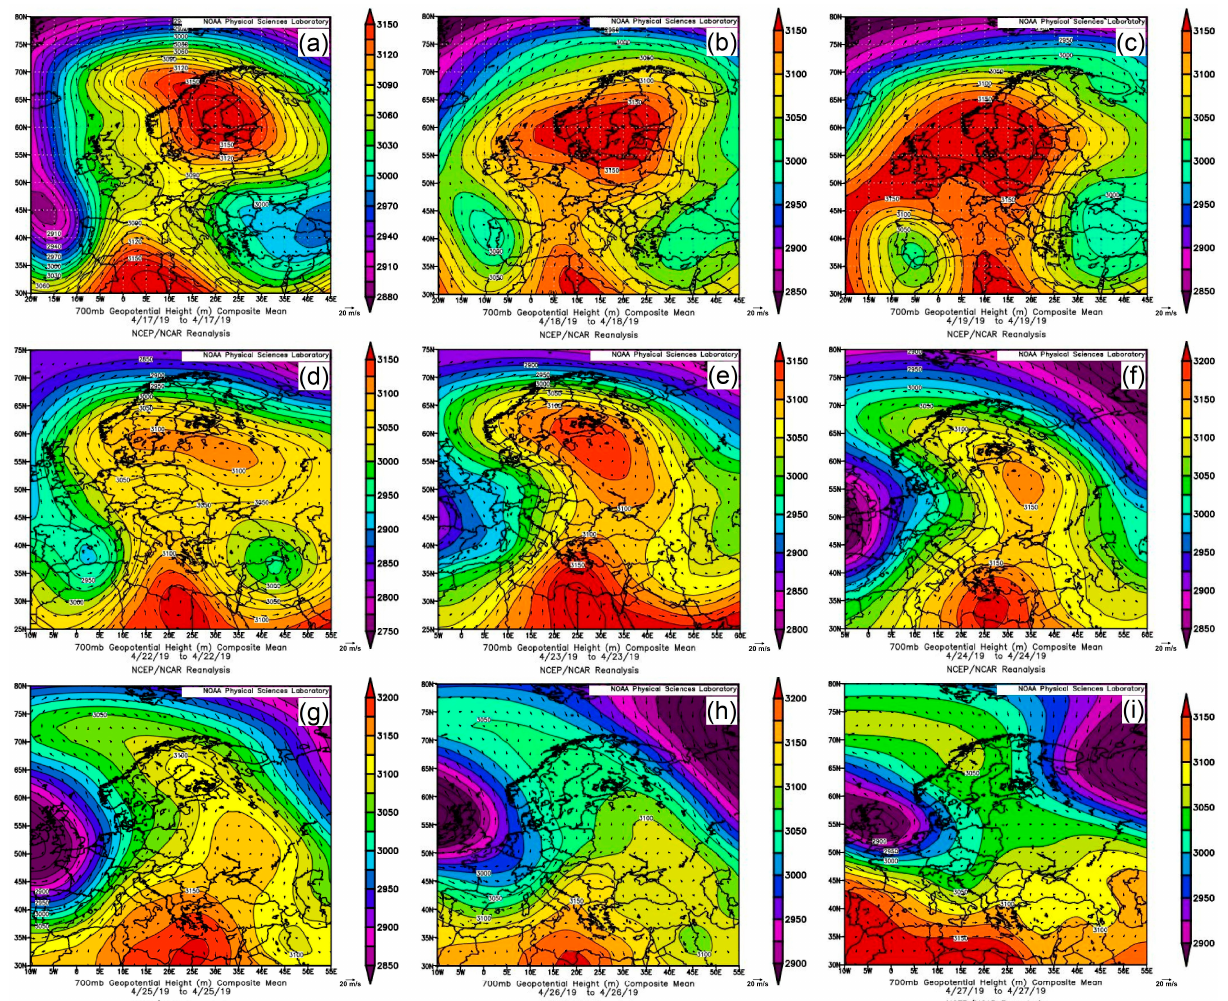
Figure 4. Synoptic meteorological situation of the Saharan dust event studied: NCEP/NCAR reanalysis composite mean of 700 mb geopotential height (shaded, units in m) and horizontal wind vectors (black arrows, units in m/s), for the period 17–27 April 2019.